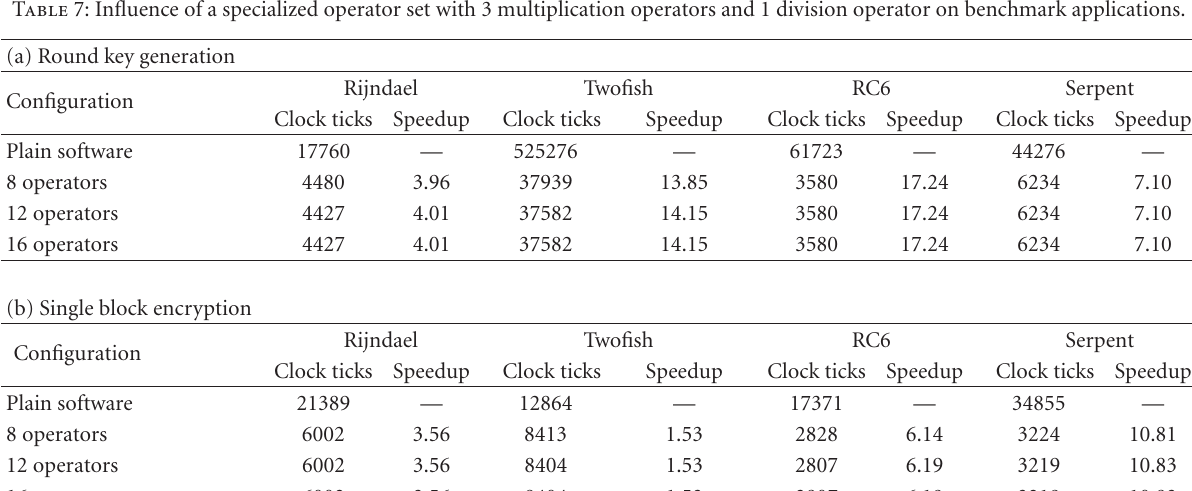
Table 7: Influence of a specialized operator set with 3 multiplication operators and 1 division operator on benchmark